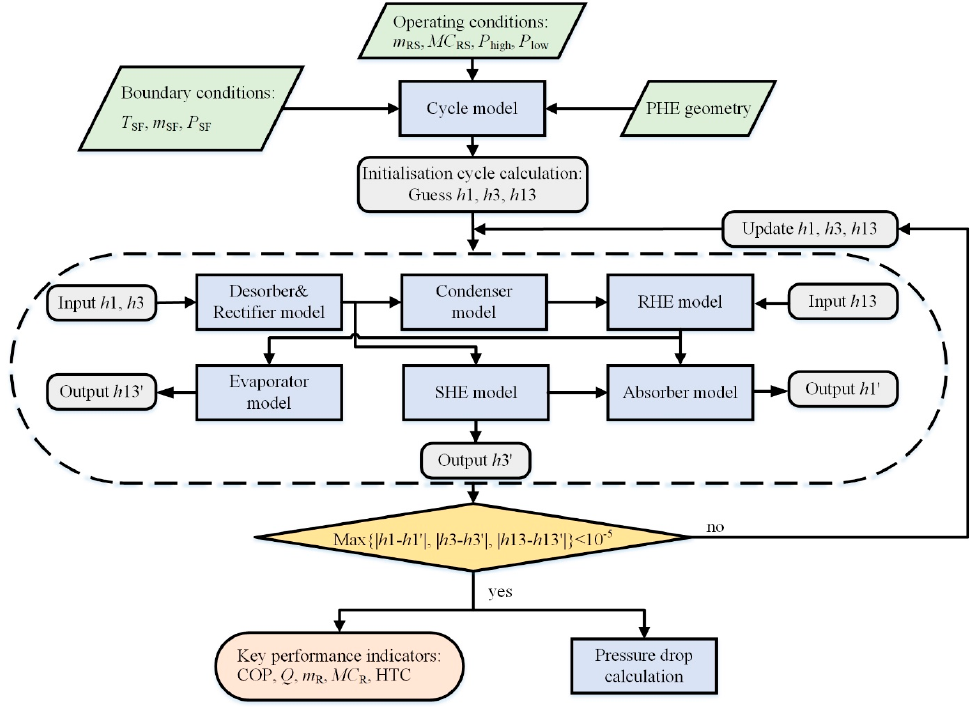
Figure 5. Simulation platform of the integrated cycle model and heat exchanger models.